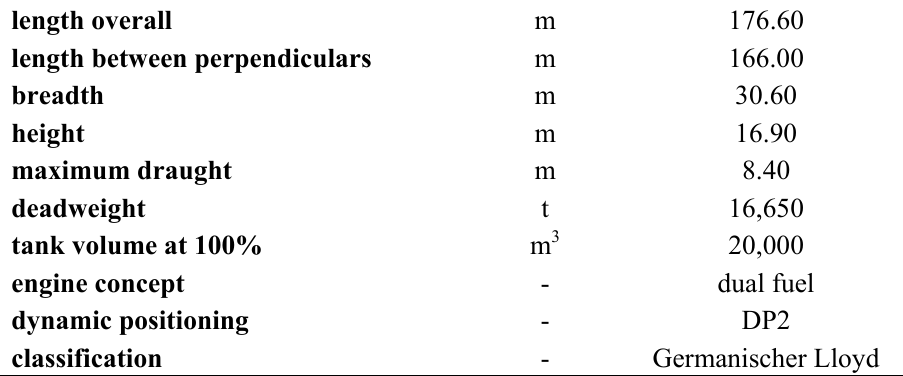
Table 1. Pellet carrier main characteristics.